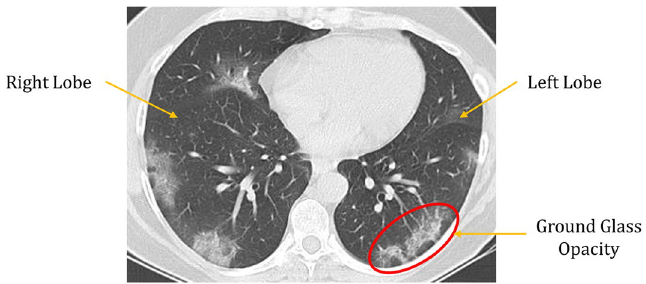
Figure 1. Example of a COVID infected Lung CT-scan image. The CT-scan image has been taken from the SARS-COV-2 dataset 15 . The ground glass opacity marked with the red circle in the image is the distinguishing feature of the COVID-19